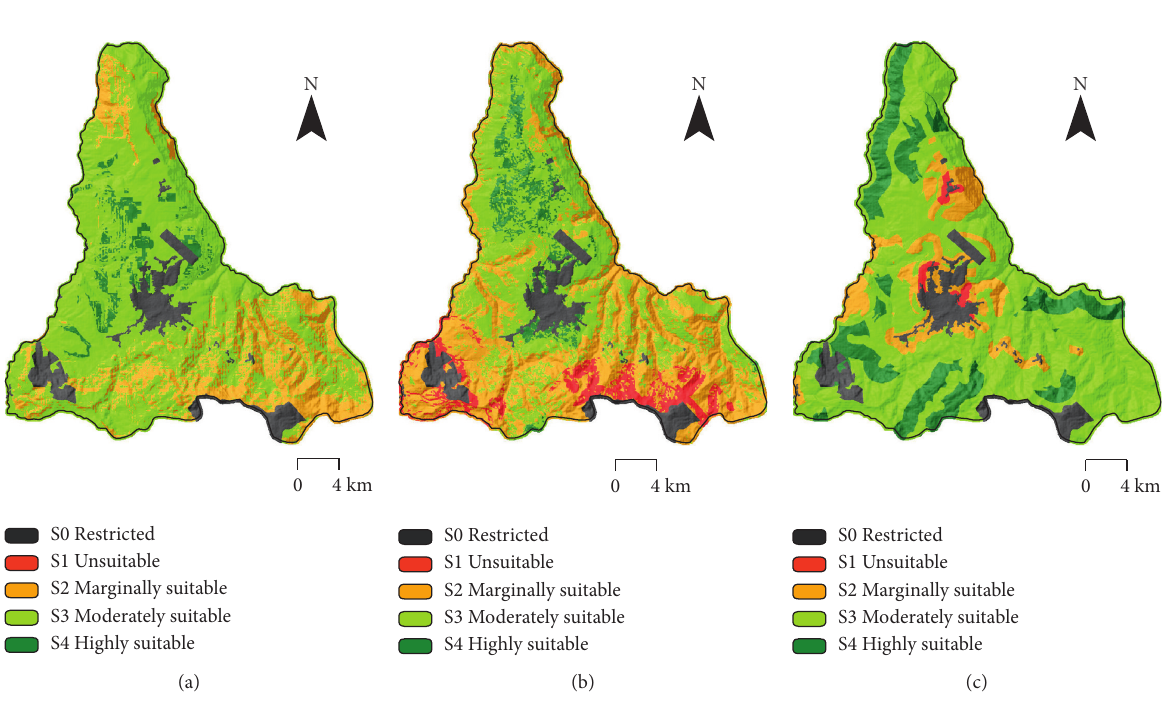
Figure 5: Maps of the physical (a), environmental (b), and socioeconomic (c) suitability submodels. Table 7: Criteria surfaces and restrictions for each suitability alternative for a future